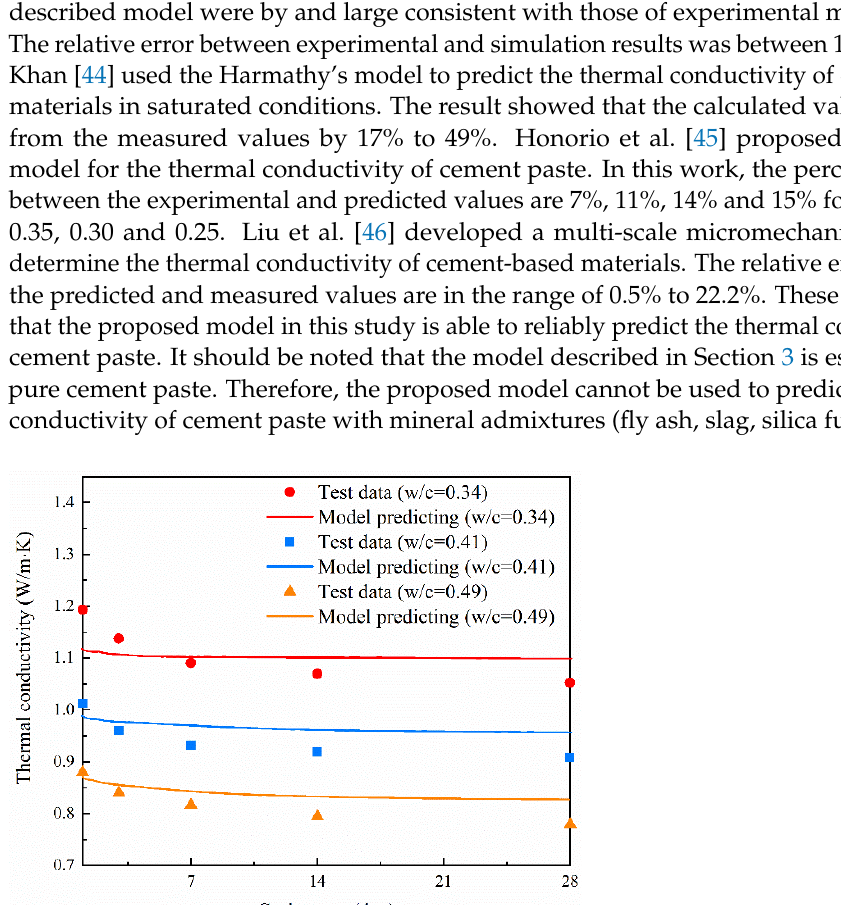
Figure 6. The simulated development of volume fraction of each phase in the cement paste during the hydration period: ( a ) and ( b ) W / C = 0.34, ( c ) and ( d ) W / C = 0.41, ( e ) and ( f ) W / C = 0.49.